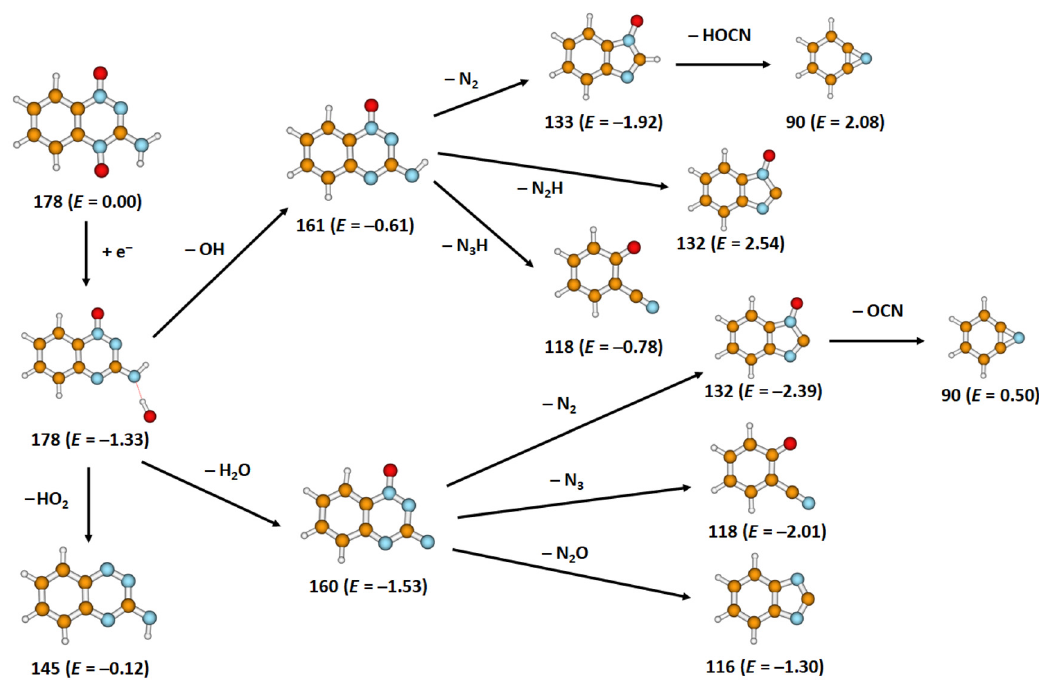
Figure 2. Suggested fragmentation pathways after electron attachment to tirapazamine starting with predissociation of the OH moiety; the mass (u) and energy E (in eV) of the respective anions are given. Calculated at the B3LYP/aug–cc–pVDZ level of theory.